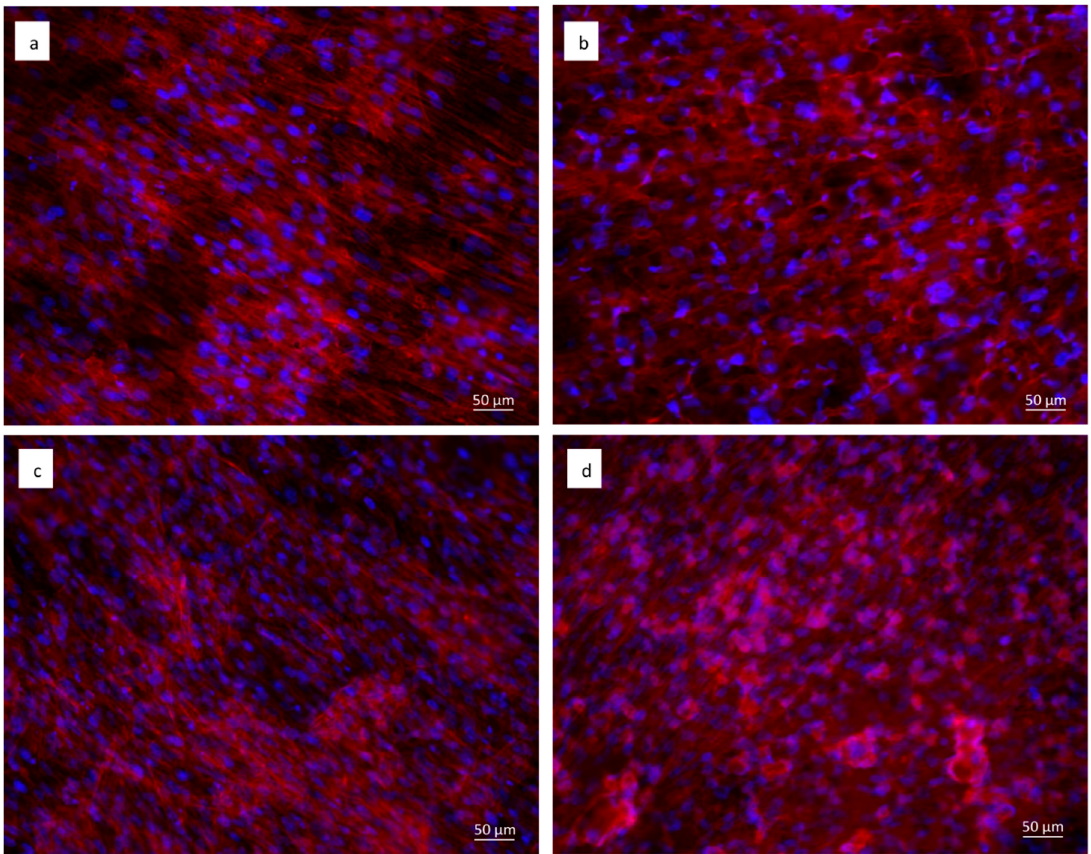
Figure 7. Immunofluorescent staining of the actin filaments with phalloidin (in red). Cell nuclei are counterstained with Hoechst (in blue). hADSCs seeded for 21 days on: ( a ) uncoated cpTi in DMEM High Glucose; ( b ) sphene-coated cpTi in DMEM High Glucose; ( c ) uncoated cpTi in Osteogenic Differentiation Medium; ( d ) sphene-coated cpTi in Osteogenic Differentiation Medium.